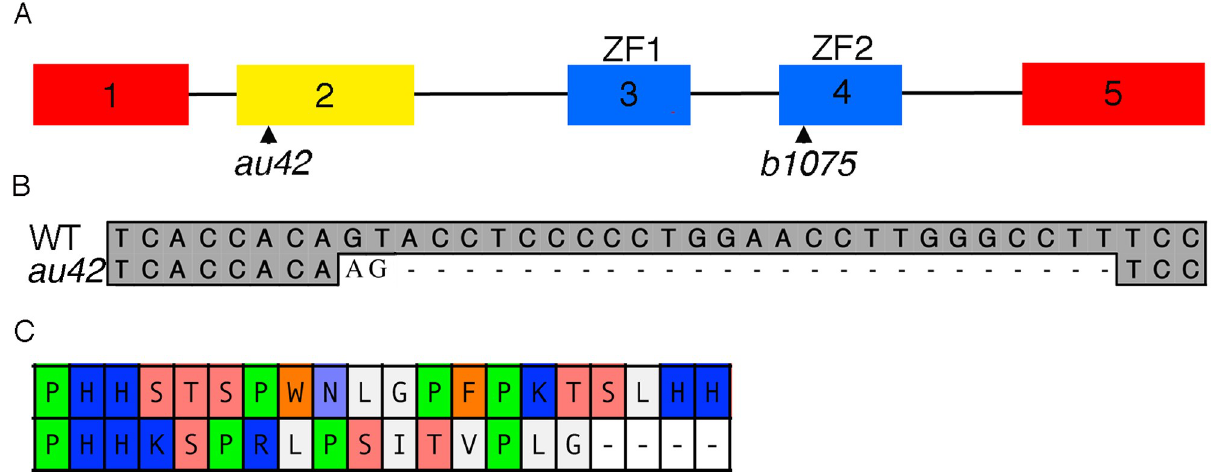
Fig 1. A null allele of gata3 generated via CRISPR-Cas9. (A) As previously reported gata3 b1075 mutation is located in exon 4. The CRISPR gata3 mutant allele au42 disrupts the second exon. (B) The gata3 au42 allele is a two base pair insertion/25 base pair deletion. (C) Predicted wild type and gata3 au42 mutant protein sequences indicates a frame shift followed by four consecutive stops in translation.